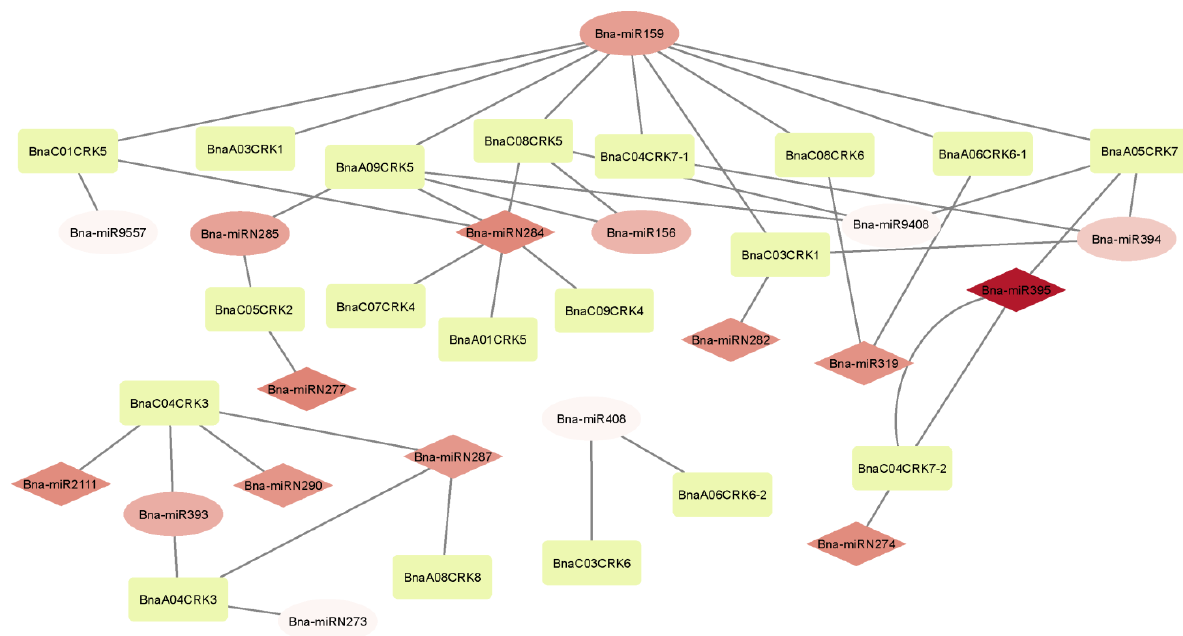
Figure 10. Interaction network of Bna-miRNAs with its targets. Bna-miRNA, whose expression was higher in response to S. sclerotiorum , is displayed in a diamond shape, while the yellow nodes represent the BnaCRKs .